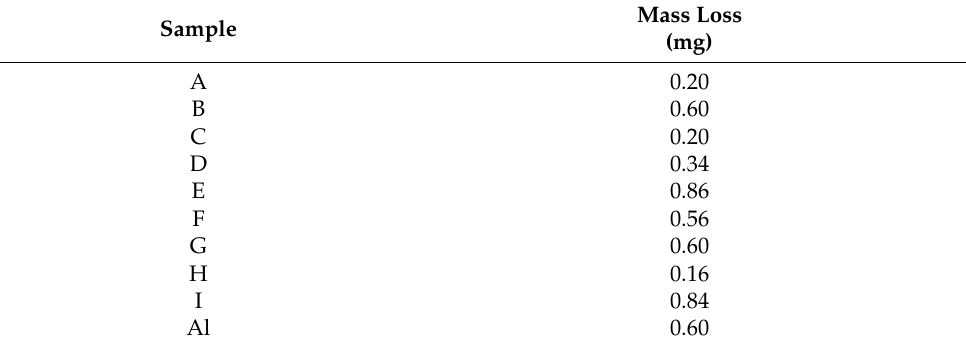
Table 4. Mass loss of the T7W mandrel in association with the samples.